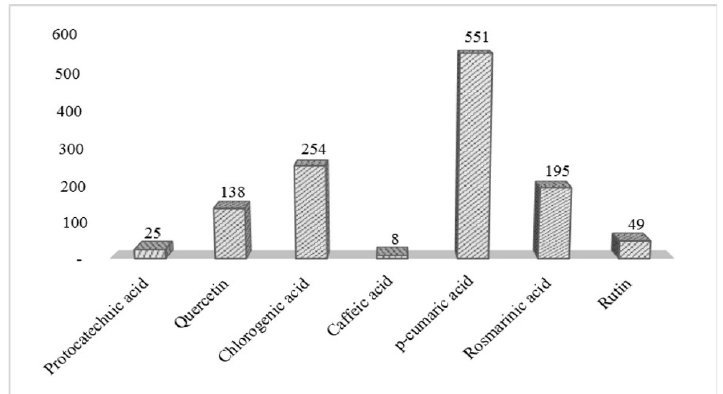
Figure 2. Individual phenolic content of fresh basil (mg kg − 1